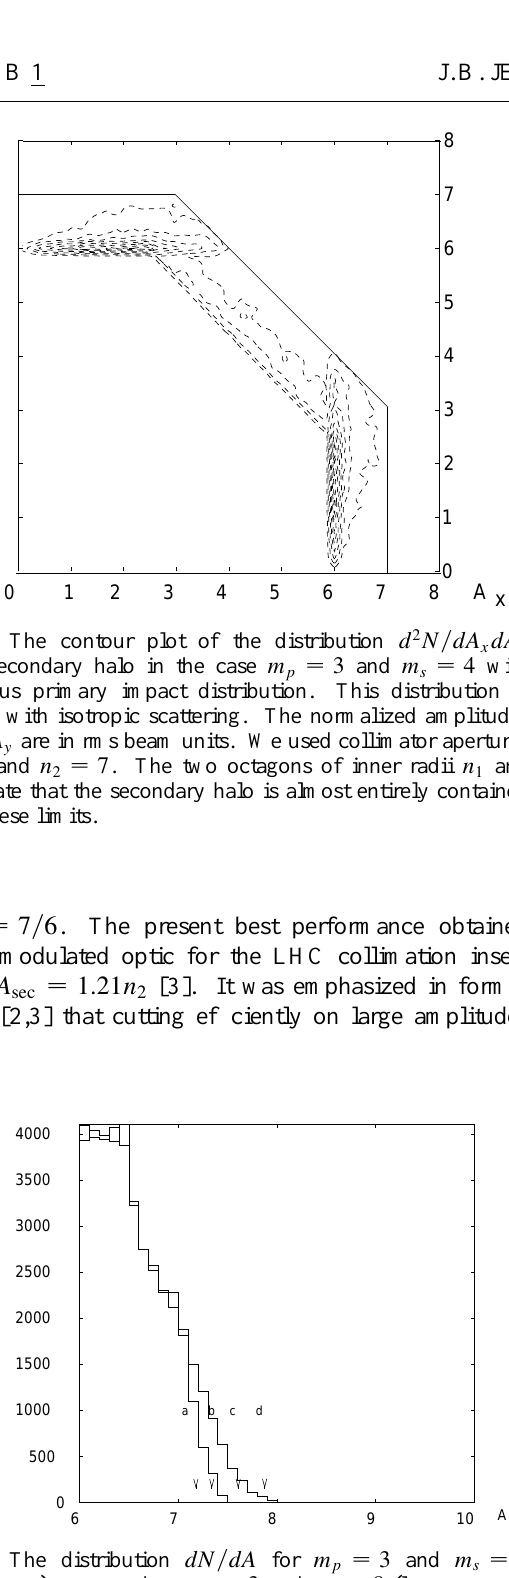
FIG. 5. The distribution (cid:100)(cid:78) (cid:121) (cid:100)(cid:65) for (cid:109) (cid:112) (cid:173) (cid:51) and (cid:109) (cid:115) (cid:173) (cid:52) (upper curve) compared to (cid:109) (cid:112) (cid:173) (cid:51) and (cid:109) (cid:115) (cid:173) (cid:56) (lower curve). We used collimator apertures (cid:110) (cid:49) (cid:173) (cid:54) and (cid:110) (cid:50) (cid:173) (cid:55) . The combined normalized amplitude (cid:65) is in normalized rms beam units. This distribution is obtained with isotropic scattering. The arrows (cid:97) and (cid:100) correspond to (cid:65) (cid:52)(cid:44) max and (cid:65) (cid:56)(cid:44) max computed with central impacts and are taken from Table II. The arrows (cid:98) and (cid:99) are the effective limits of Eq. (23) for the same two cases. The latter ones are much better estimators of the upper limits if the fading ends of the spectra are